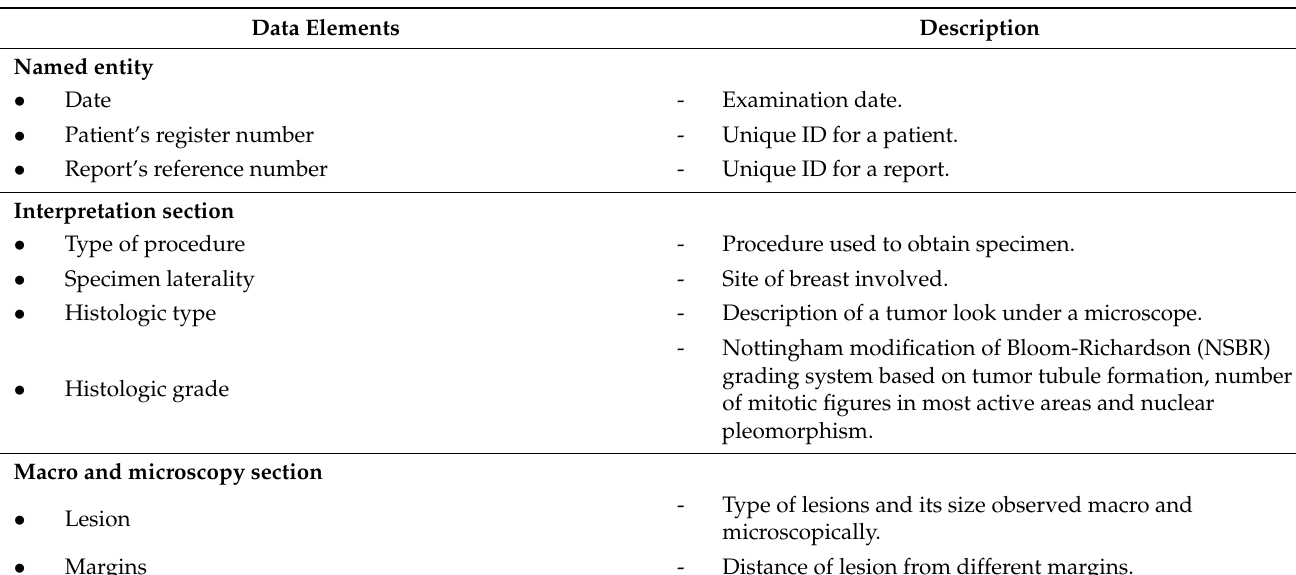
Figure 2. Overview of study. Table 1. Key elements identified by the pathologist in UMMC.